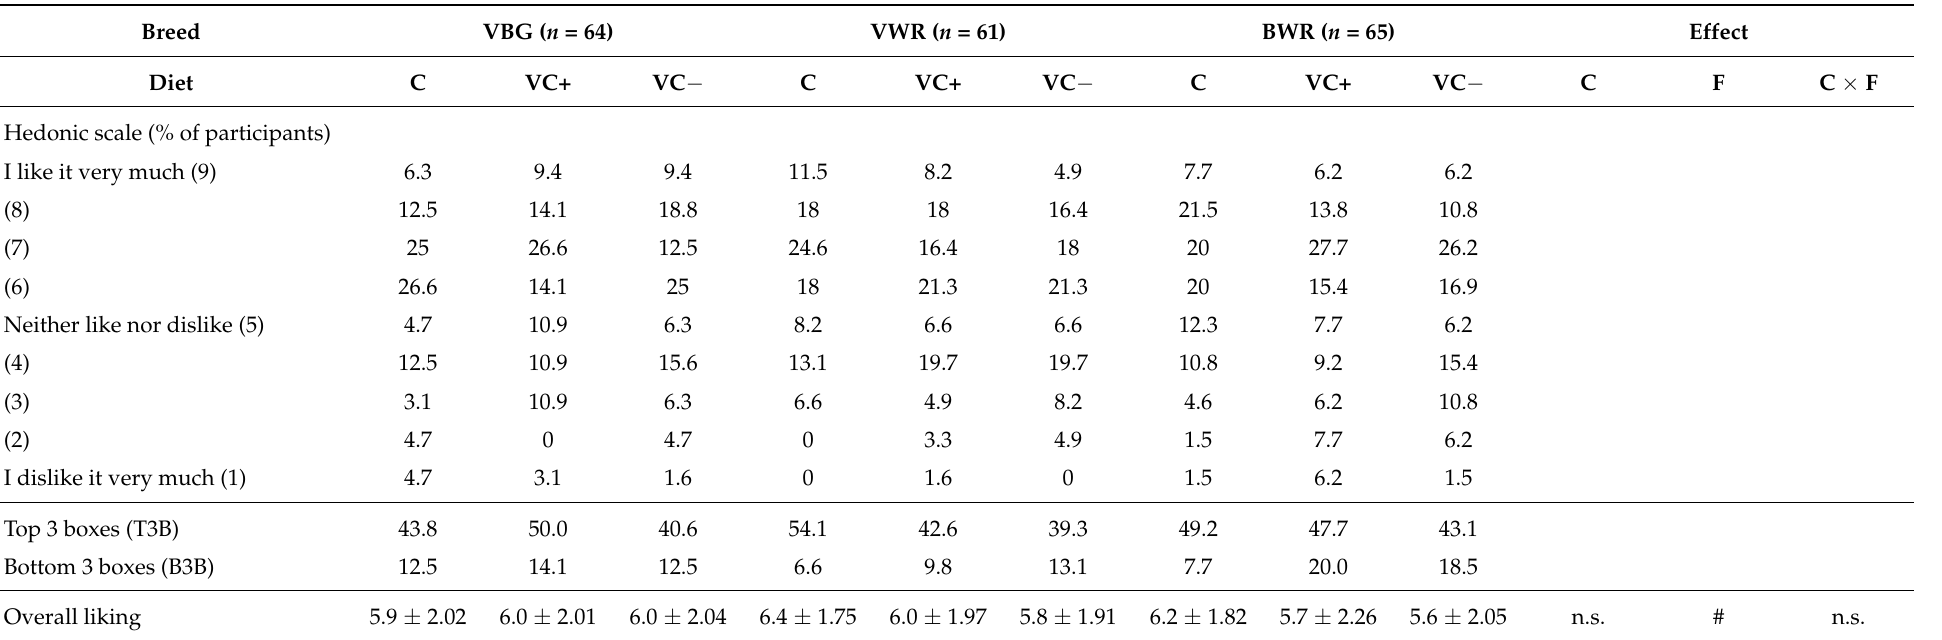
Table 6. Consumers’ acceptance of chicken